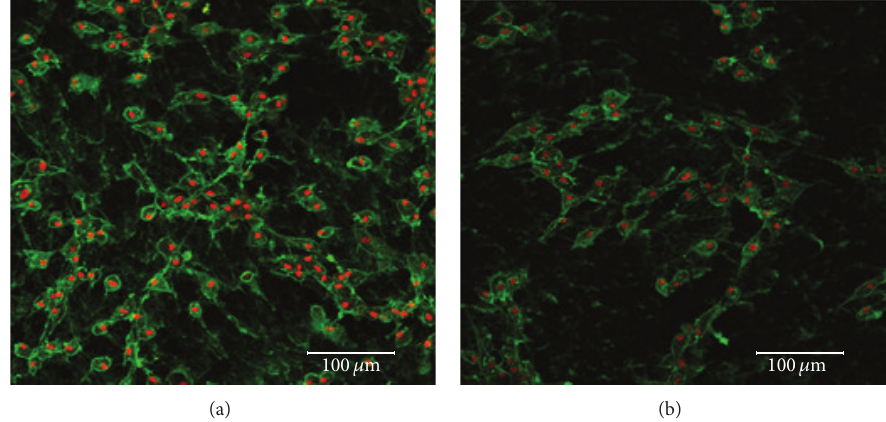
Figure 6: Nuclear/cytoplasmic staining of neural-like eBM-MSCs on different substrates. Representative confocal images of cytoplasmic (WGA) and nuclear (TO-PRO-3-iodide) fluorescent stains showing survival of differentiated cells from one middle-aged horse 12h after chemical induction, on Primaria, nitrogen-coated (a) and polystyrene-coated (b) tissue culture plates. Note scarce cells on the polystyrene tissue culture plate. Scale bar = 100 𝜇 m.